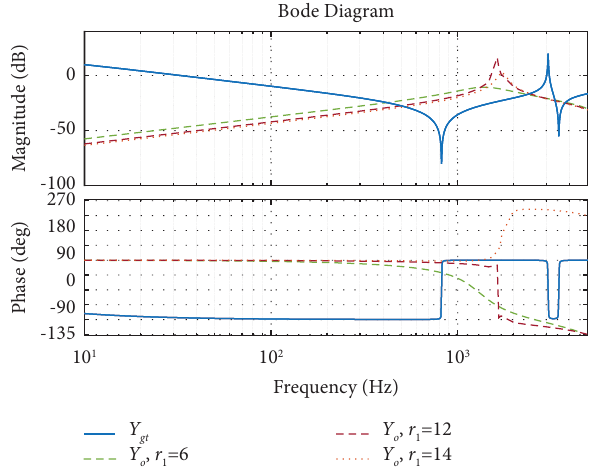
o ( s ) with diferent r 1 and the